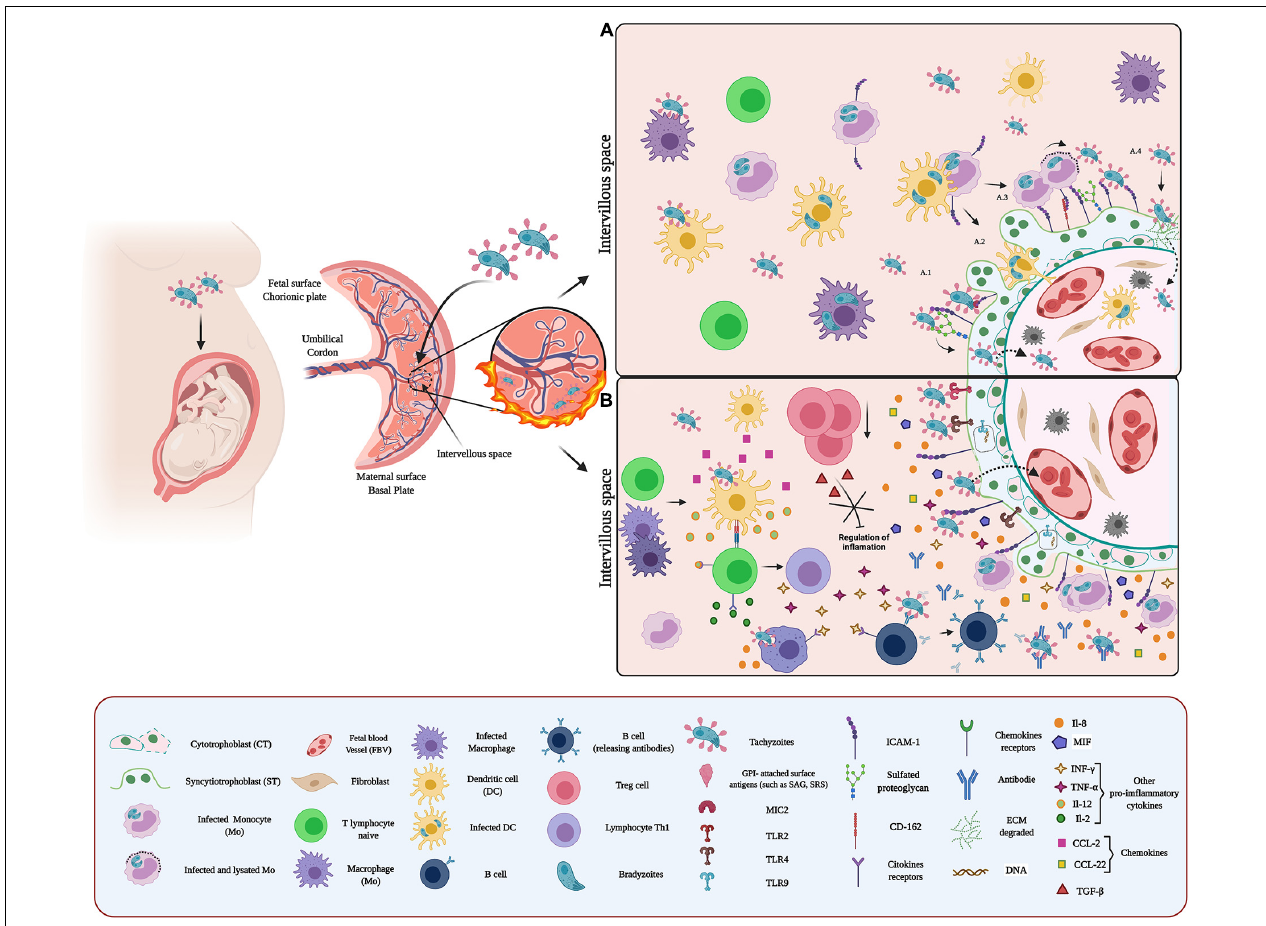
FIGURE 3 | Host–pathogen interaction between Toxoplasma and placenta: (A) Adhesion of T. gondii in the placenta. Toxoplasma adhesion to the placenta can occur through proteins belonging to the SAG, SRS, and MIC families. These proteins expressed on the surface of the parasite act as surface antigens and ligands for molecules present on the surface of placental cells. These surface antigens could bind to GAGs, glycoproteins, adhesion molecules, and some extracellular matrix components. Once attached to the placenta, T. gondii crosses the placenta by different mechanisms: (i) without altering the integrity of the barrier (A.1) ; (ii) infecting immune cells (such as CDs) and using them as Trojan horses (A.2) ; (iii) exploiting the natural routes of leukocytes extravasation and coordinating its exit with the arrival at the target organ, thus minimizing attack by the immune system during the vehicle transition to target cells (A.3) ; and (iv) and promoting EMC degradation, through modulation of MMP expression and secretion (A.4) . (B) Microenvironment and inflammatory response against T. gondii . Recognition of T. gondii by TLR (TLR2/4/9) induces IL-8 expression and secretion. Additionally, infection by this parasite promotes the expression of MIF and CCL-2. Recognition of the parasite by immune cells (such as CDs and M (cid:56) ) activates an inflammatory response characterized by cytokine and chemokine production such as IL-12, CCL-2, and CCL-22, which activate naive T cells. Subsequently, these cells differentiate to Th1 and produce cytokines (such as IL-2, INF- γ , and TNF- α ) that promote an exacerbated pro-inflammatory environment, which stimulates the recruitment and activation of other immune cells at the site of infection. Additionally, infection by T. gondii promotes a decrease in Tregs, contributing to the exacerbated inflammatory